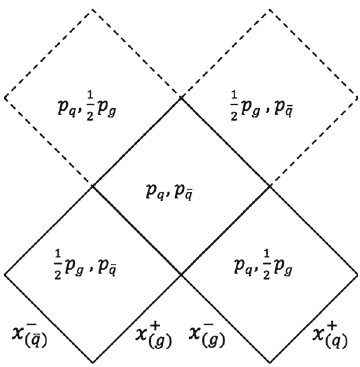
Fig. 7 The parameter plane picture for the qg ¯ q system. The dash lines indicate the turnover regions, normally neglected